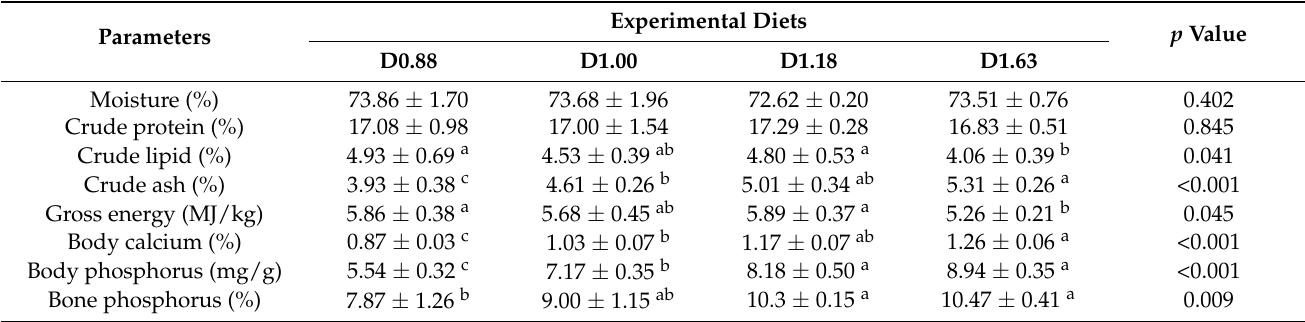
Table 4. Whole-body proximate composition (wet weight) and bone phosphorus (dry weight) in Chinese soft-shelled turtle fed with different phosphorus diets.